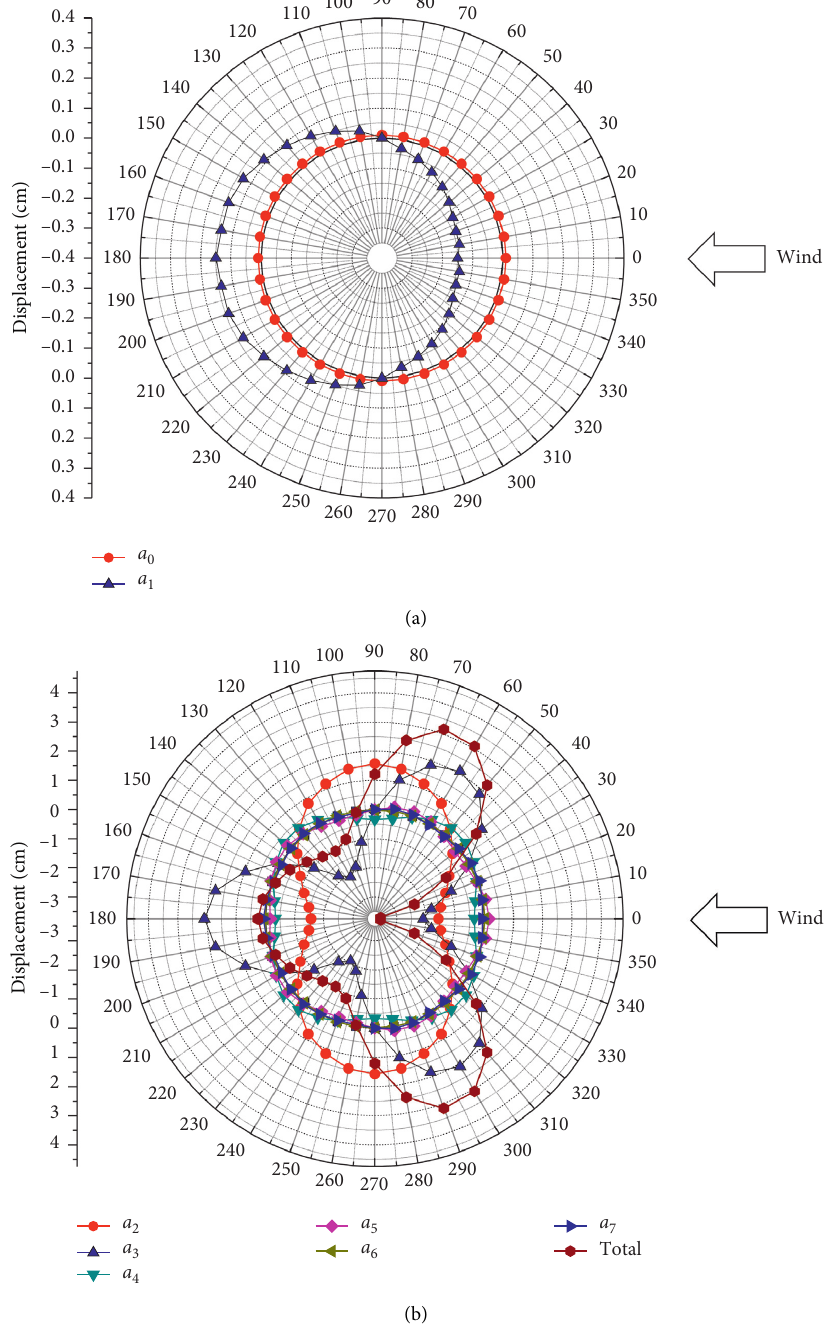
Figure 15: Radial displacement of each harmonic component for rib curve in China code (throat). (a) Displacement of DC and first-order harmonic component. (b) High-order harmonic component displacement and total